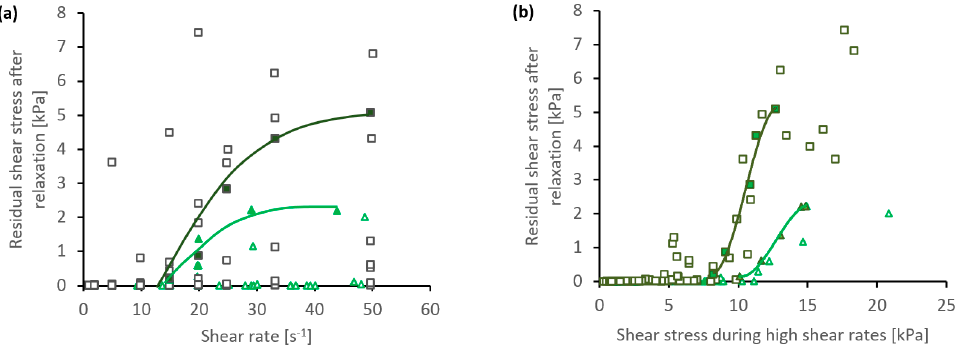
Figure 5. Comparison between residual stress after quasi-static relaxation (100 s at γ(cid:4662) = 0.0005 s − 1 ) and ( a ) shear rate or ( b ) shear stress during the periods of faster flow (of total strain 30 or 100, shown as triangles or squares, respectively). Filled points represent exemplar data from individual experiments; open points represent aggregated data from several experiments. The continuous lines show trend lines for the exemplars.